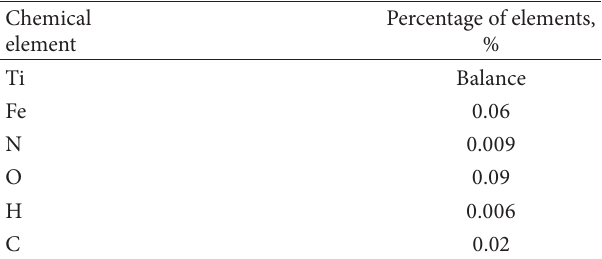
Table 3: Chemical composition and percentage of elements of Titanium Grade (cid:3) 2 alloy (1) .